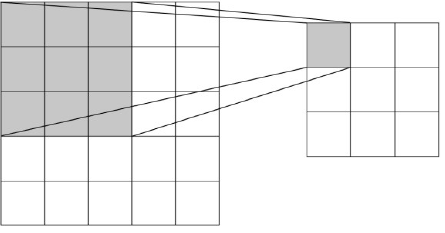
Figure 3. Convolution operation process of the CNN model.